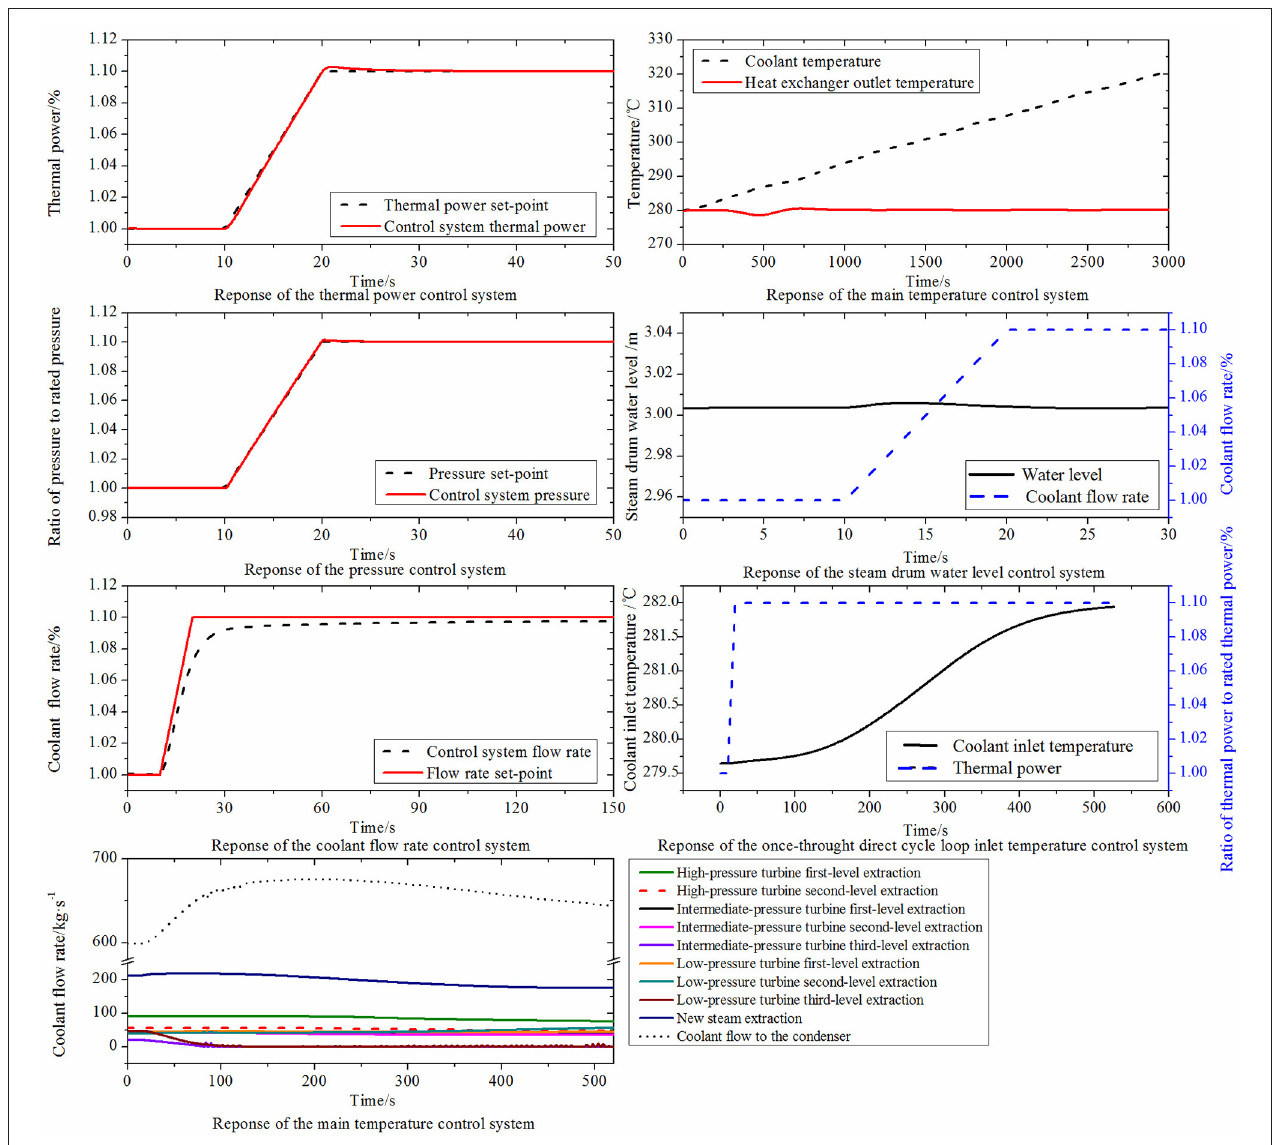
FIGURE 8 | Control capability of control systems under disturbance